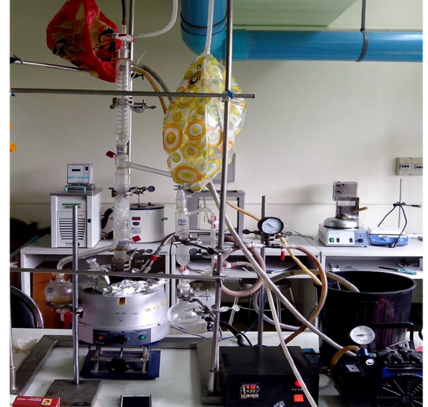
Figure 1. Laboratory scale pyrolysis process.